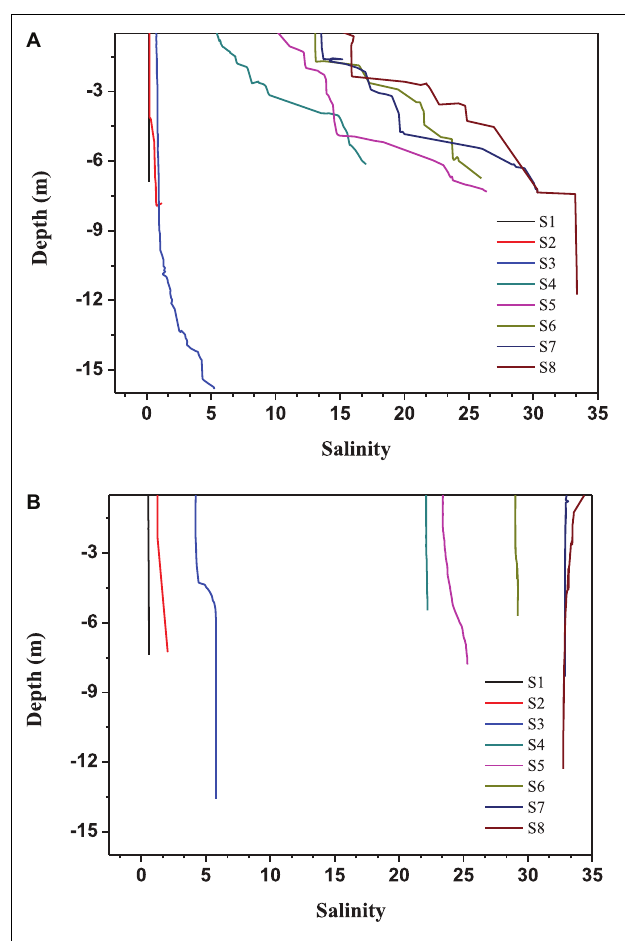
FIGURE 2 | Vertical distribution of salinity in the Pearl River estuary in (A) August 2016 and (B) January 2017.